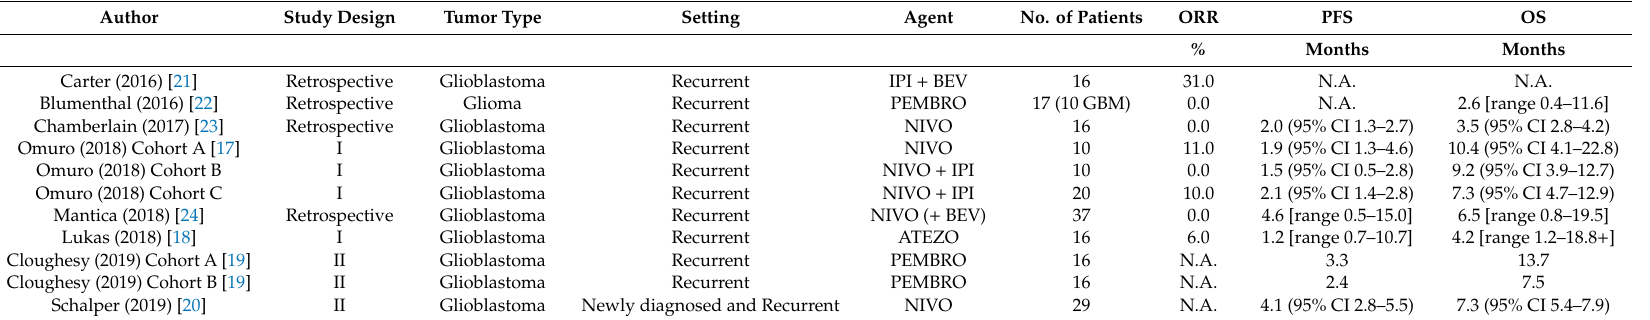
Table 1. Primary outcomes of clinical studies with immune checkpoint inhibitors in patients with